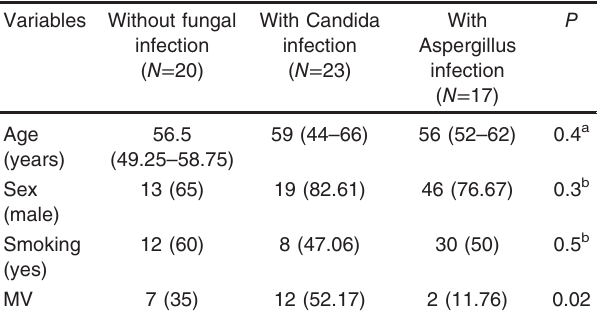
Table 5 Length of stay in ICU and mechanical ventilation use in correlation with fungus infection Variables